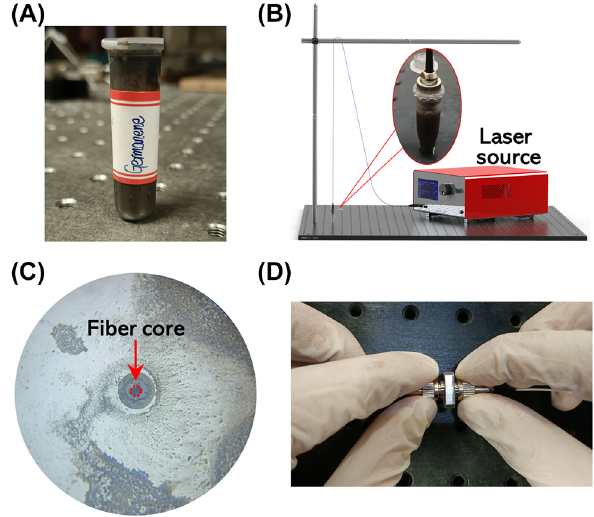
Figure 3: Optical deposition of germanium NSs. (A) Photograph of high concentration germanene dispersion; (B) experimental device diagram of laser-induced deposition method; (C) fiber facet with germanene after optical deposition; and (D) self-assembly conducted